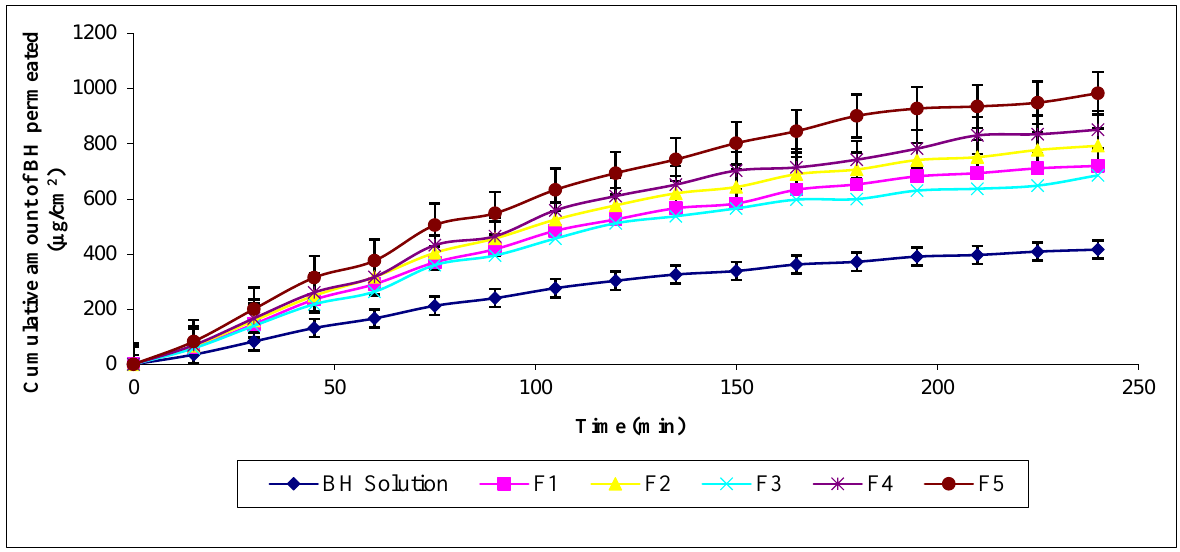
Figure 3. Ex vivo permeation profiles of BH hydrogels (lacking permeation enhancers) compared to BH solution by iontophoresis through rat skin.